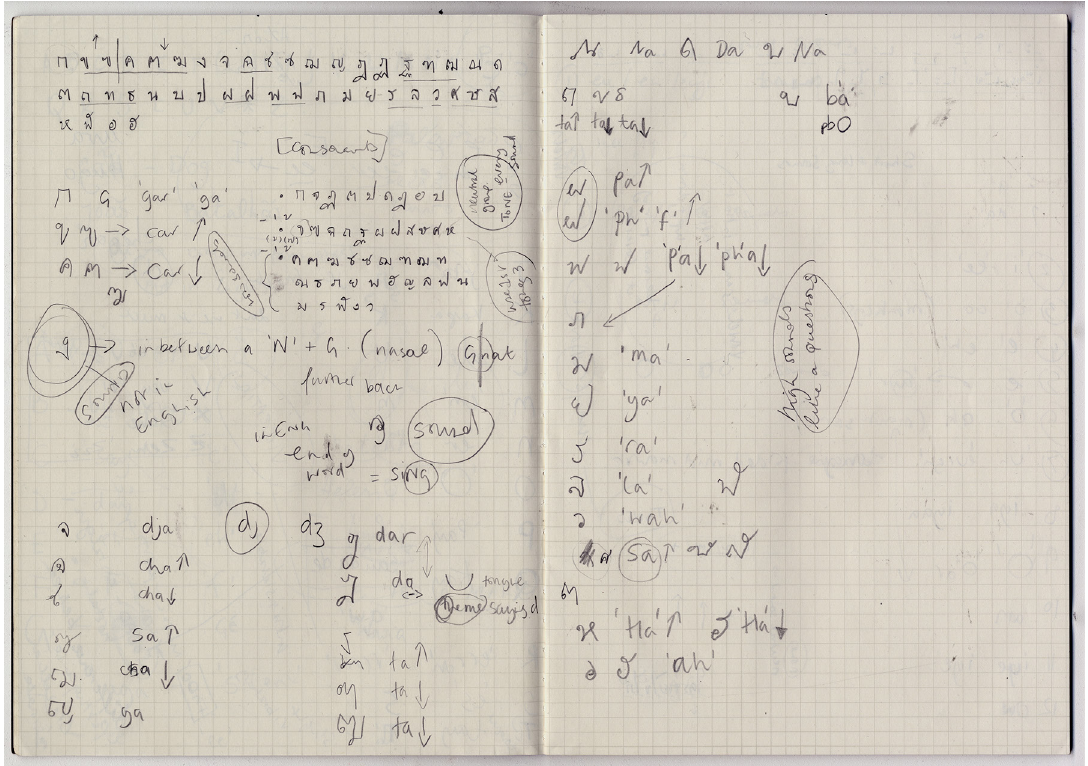
Figure 2. Example of the notes taken during initial discussions with Thai and Finnish